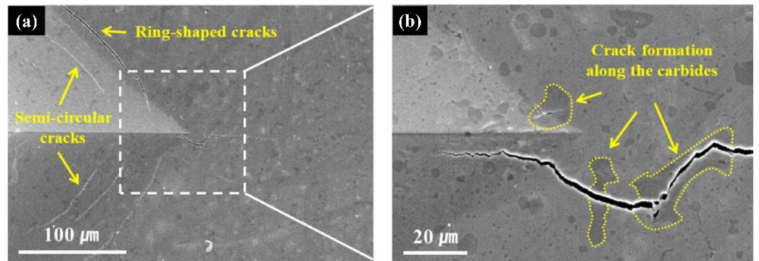
Figure 8. SEM images of the nitrided surface (compound-free) showing ( a ) semi-circular cracks and ( b ) crack formation along the coarse